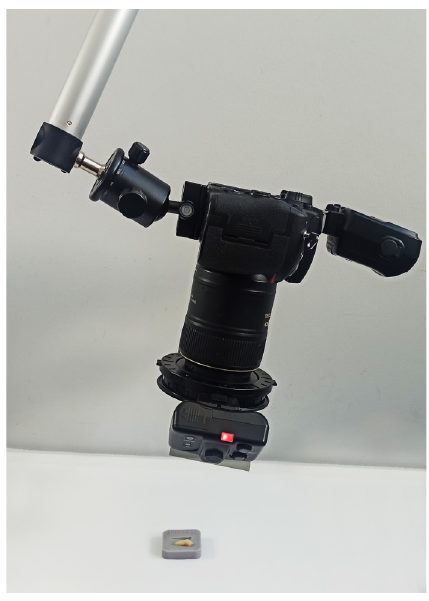
Figure 3: CP Photography shooting